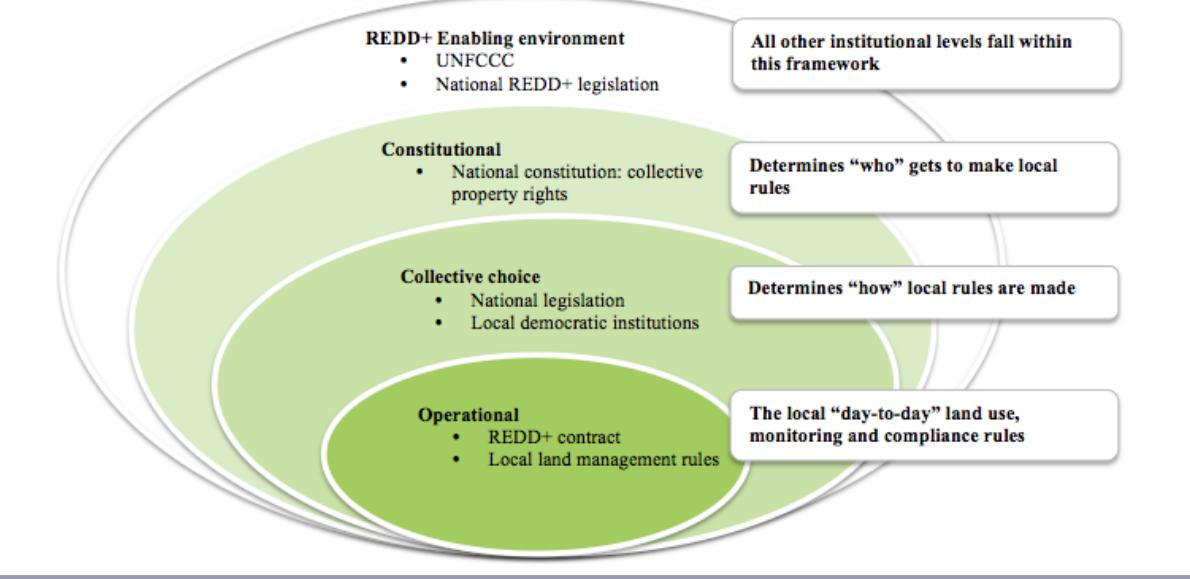
Fig. 3 . Multilevel institutional framework proposed for REDD+. The three community-level institutions (green) fit within the REDD+ enabling environment, and the REDD+ enabling environment is supportive of local institutional development on the constitutional, collective-choice, and operational levels. REDD+ indicates Reducing Emissions from Deforestation and Forest Degradation; UNFCCC, United Nations Framework Convention on Climate